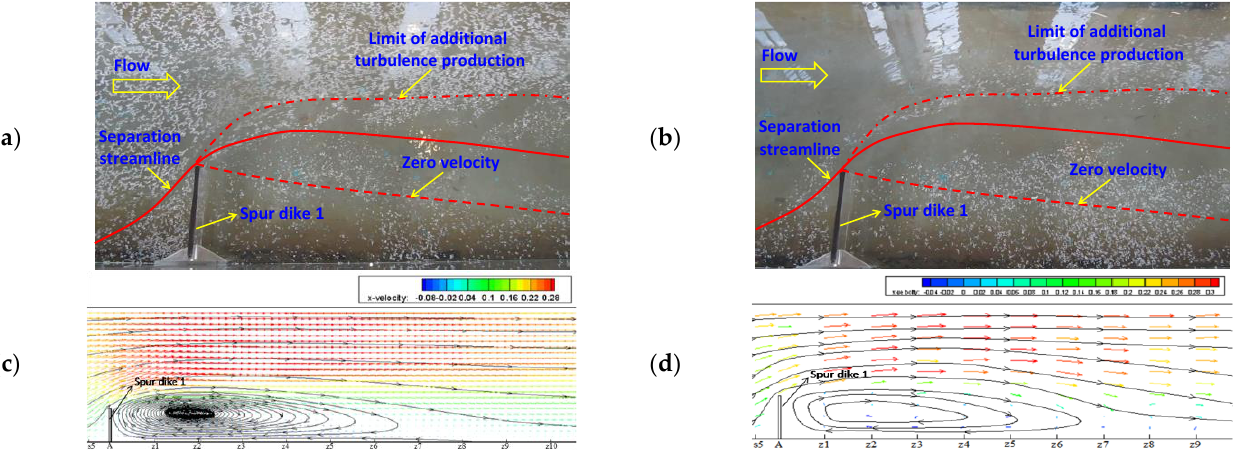
Figure 5. The flow structure near spur dike 1: ( a ) surface image in initial stage of visualization, ( b ) surface image in last stage of visualization, ( c ) numerical result on the horizontal plane of Y = 0.08 m, and ( d ) experimental result on the horizontal plane of Y = 0.08 m.